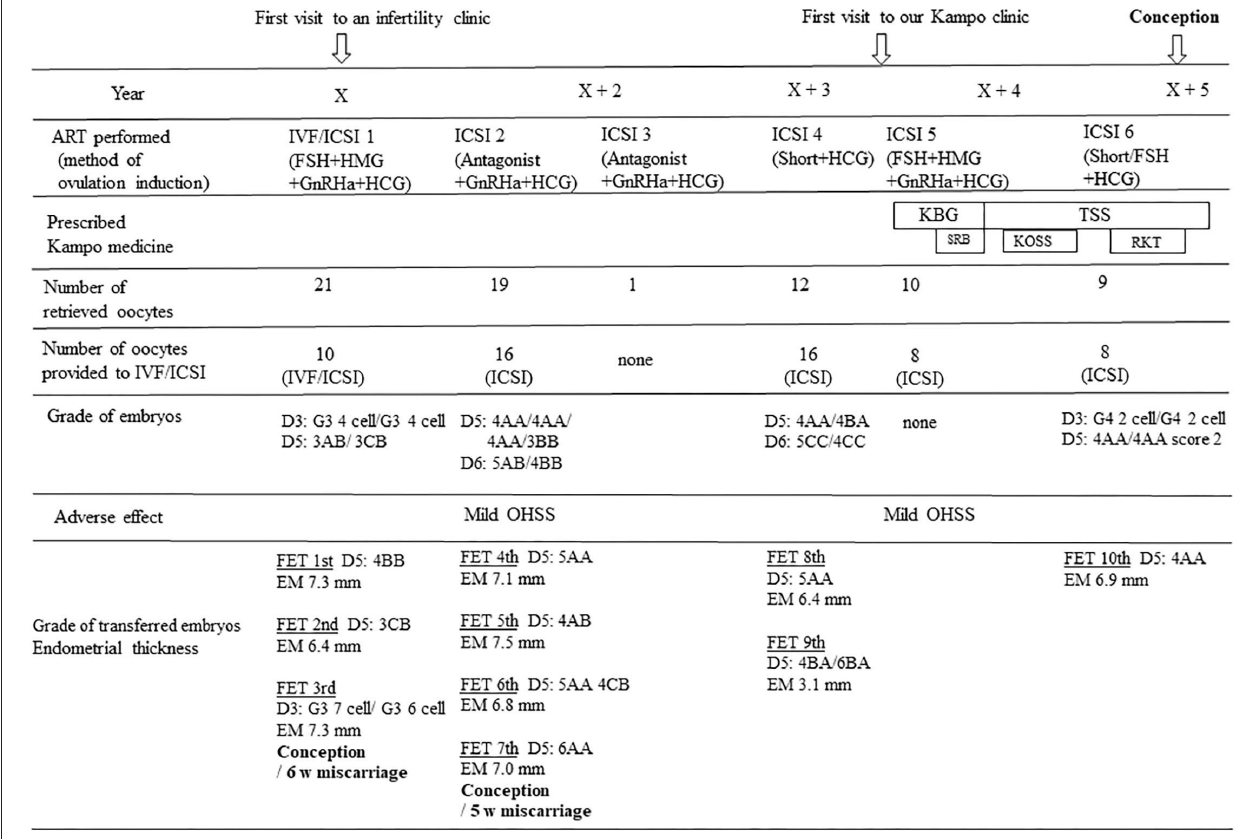
FIGURE 1 | Time course of the treatment and results. There were no changes in number of oocytes retrieved for IVF/ICSI, grade of fertilized eggs and thickness of uterine endometrium before and after the addition of Kampo treatment to ART. The blastocyst score was determined according to Gardner’s grading system, and early-stage embryos were evaluated with Veeck’s criteria. IVF, in vitro fertilization; ICSI, intra cytoplasmic insemination; FSH, follicular stimulation hormone; HMG, human menopausal gonadotropin; GnRHa, gonadotropin releasing hormone agonist; HCG, human chorionic gonadotropin; Short, short protocol; KBG,